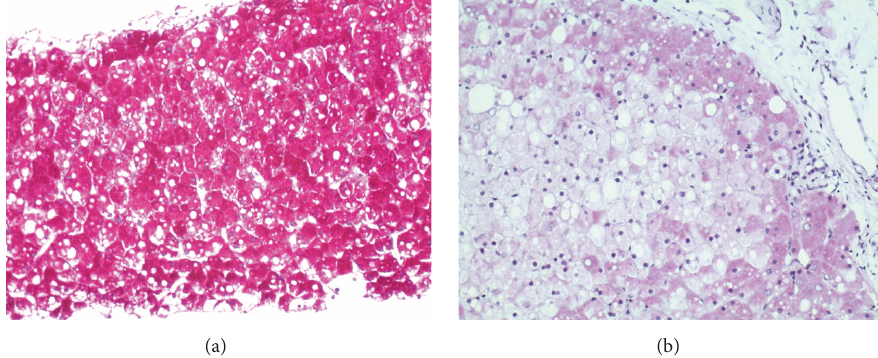
Figure 2: (a) 200x magnification PAS stain (without diastase) to show bright red staining of hepatocyte cytoplasm. (b) 200x PAS stain with diastase (to break down glycogen) to show marked decrease in bright red staining of hepatocyte cytoplasm, indicating the amount of glycogen present before. The clear vacuoles are consistent with lipid